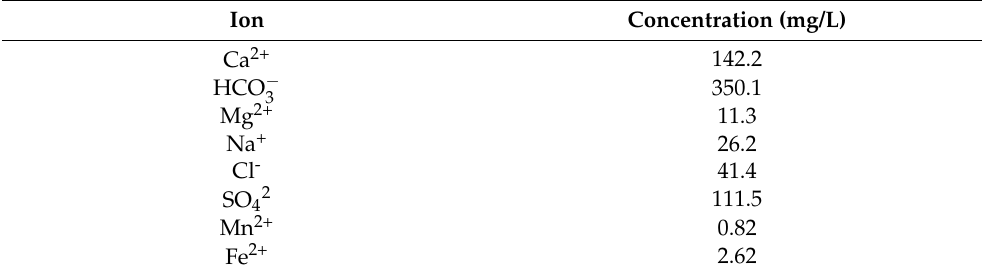
Table 1. Average concentration of ions in the chalk aquifer of the Mons Basin